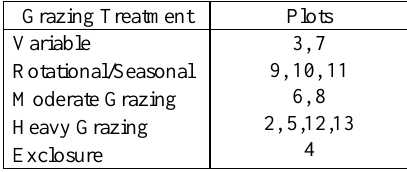
Table. 1. Grazing treatment associated with each field plot